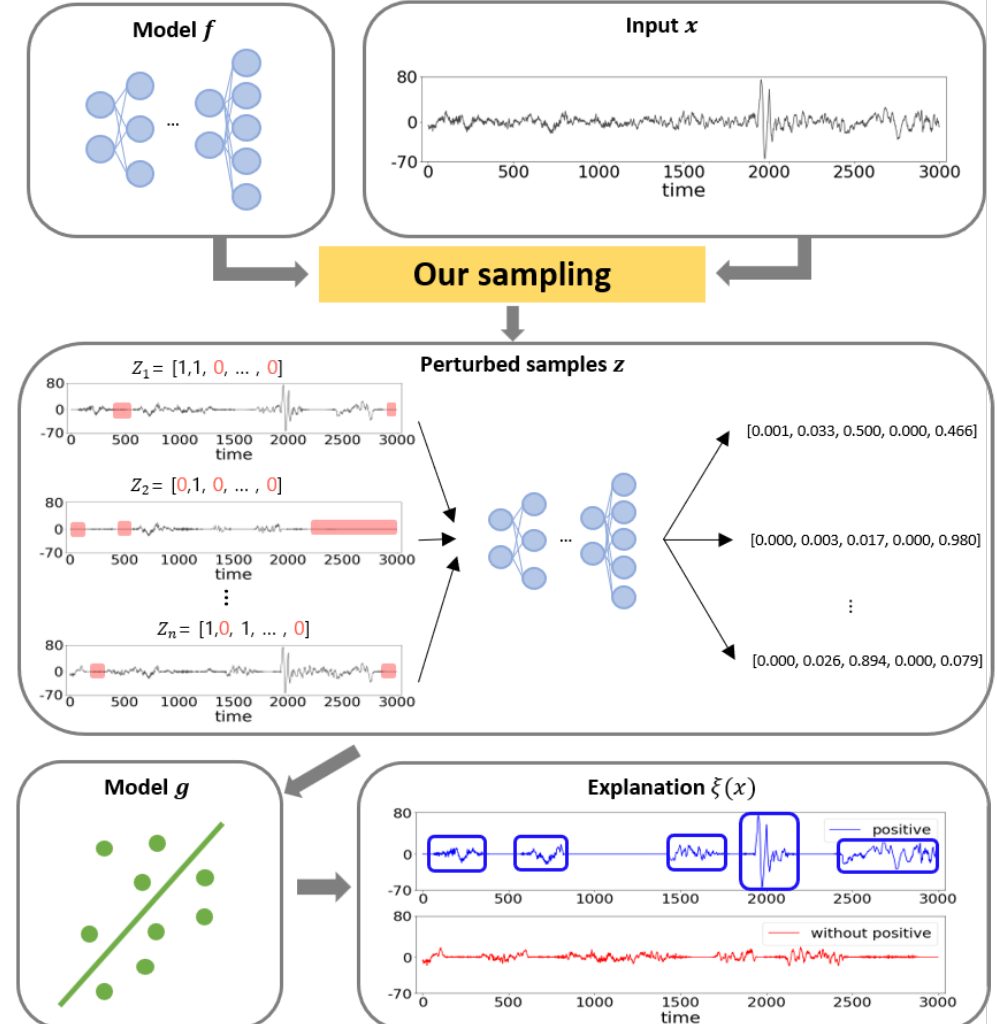
Figure 1. Given the target model f , which is to be explained, and the input signal x , which is an EEG signal, the explanation ξ ( x ) is obtained using the surrogate model g , which is easily interpretable as a linear model. The model explanation ξ ( x ) depends on the perturbed samples z